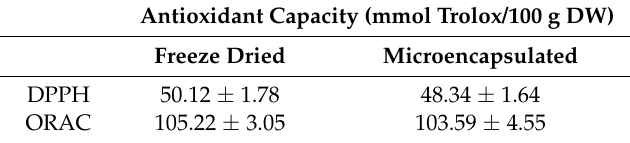
Table 4. Antioxidant capacity in freeze dried and microencapsulated banana passion fruit pulp.